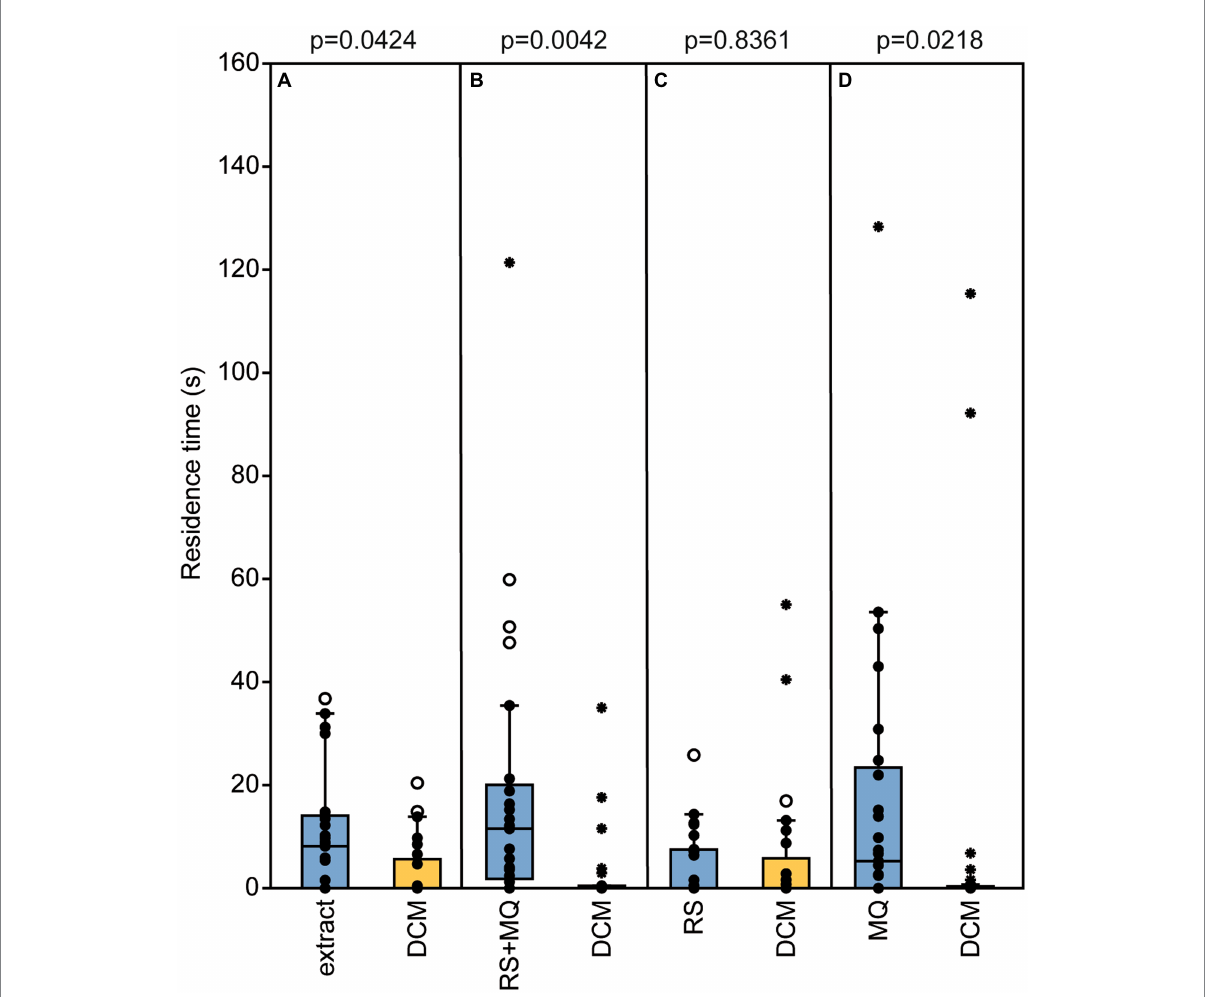
FIGURE 5 Nasonia longicornis males are arrested by their own pheromone. Residence time of unmated N. longicornis males in the two odor fields of a static two-choice olfactometer when given the choice between dichloromethane (DCM, control) and (A) one male equivalent of a natural N. longicornis pheromone extract, (B) a combination of 200 ng of synthetic (4 R ,5 S )-5-hydroxy-4-decanolide (RS) + 0.5 ng 4-methylquinazoline (MQ), (C) 200 ng RS, and (D) 0.5 ng MQ. Box and whisker plots show median (horizontal line), 25%–75% quartiles (box), maximum/minimum range (whiskers) and outliers ( ° >1.5 × above box height; *>3 × above box height; n = 25, data analysis by a Wilcoxon matched-pairs